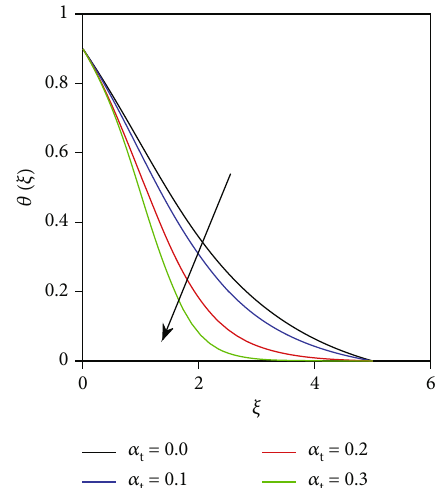
Figure 14: Temperature pro fi les for thermal relaxation parameter α . t